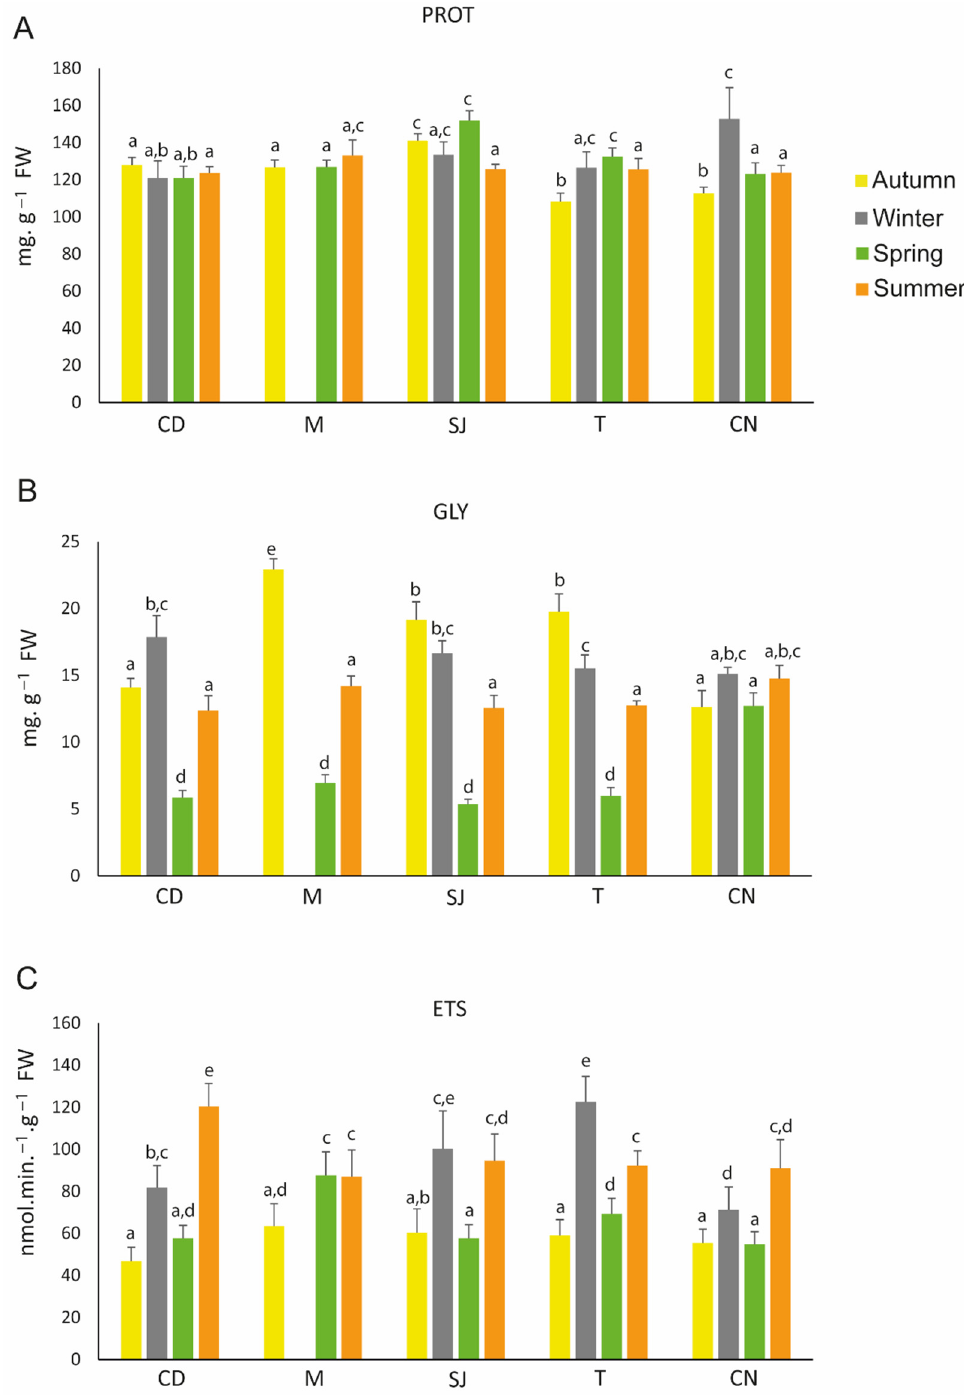
Figure 4. Metabolism-related parameters: ( A ) protein (PROT), ( B ) glycogen (GLY), and ( C ) electron transport system (ETS) measured in Diopatra neapolitana in autumn 2018 and winter, spring, and summer 2019. Comparison between different seasons at the same site. Letters (a–e) represent significant differences between areas and seasons ( p ≤ 0.05). CD: Cale do Ouro; M: Murtosa; SJ: São Jacinto; T: Torreira; CN: Costa Nova. Site M has no winter data.